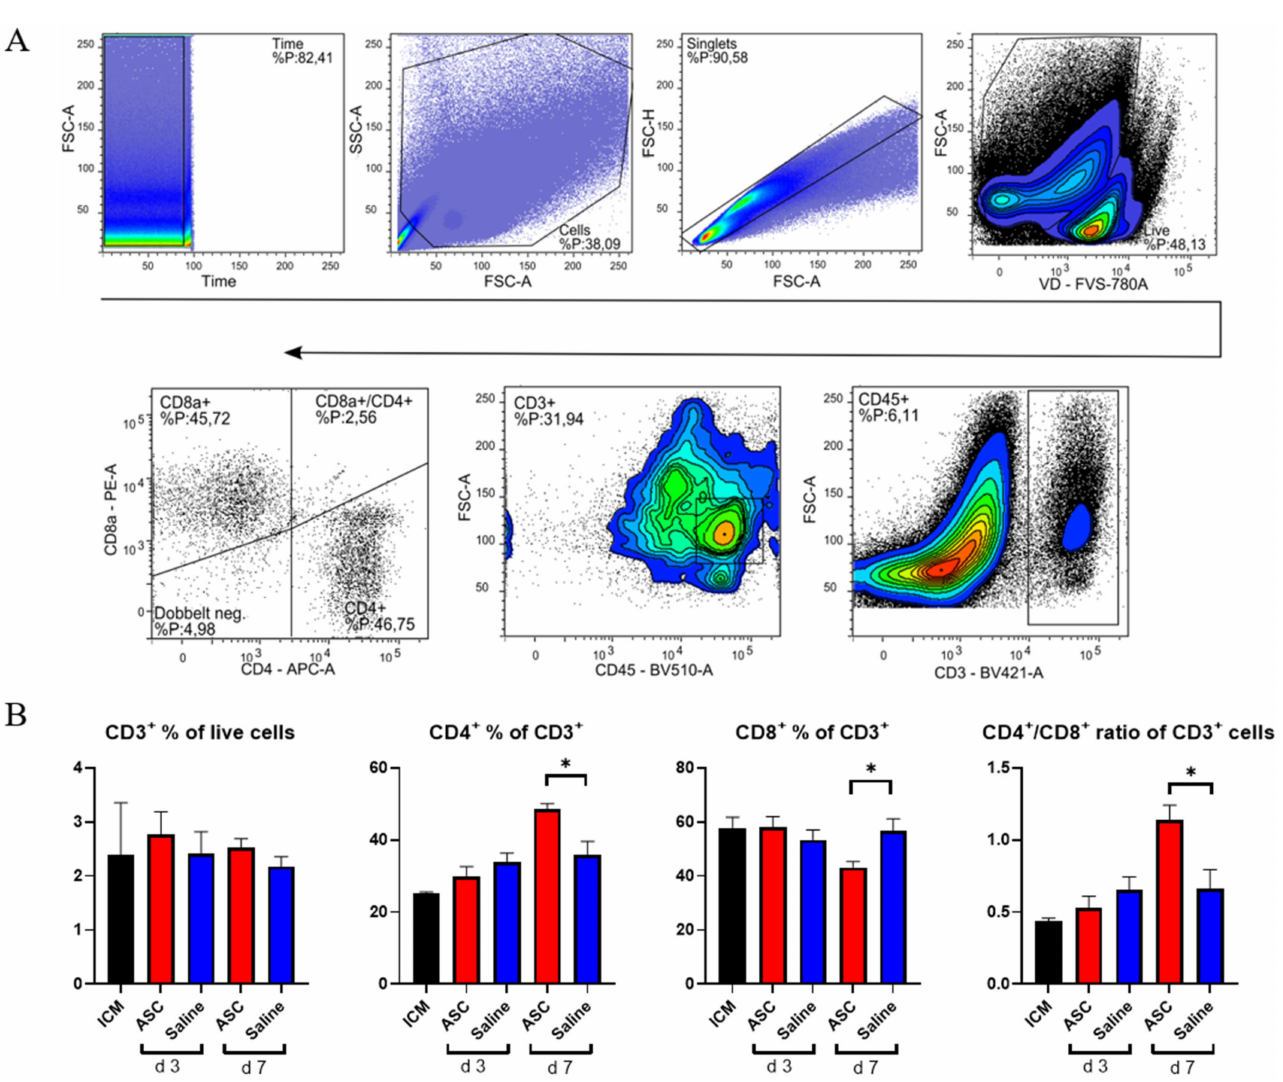
Figure 5. T-lymphocyte response to ASC and saline administration. ( A ) Gating for T-lymphocytes. ( B ) Effect on CD3 + cells, CD4 + , CD8 + , and the CD4 + /CD8 + ratio. ICM n = 3, ASC day 3 n = 4, saline day 3 n = 4, ASC day 7 n = 5, and saline day 7 n = 4. ICM; ischemic cardiomyopathy. * p <